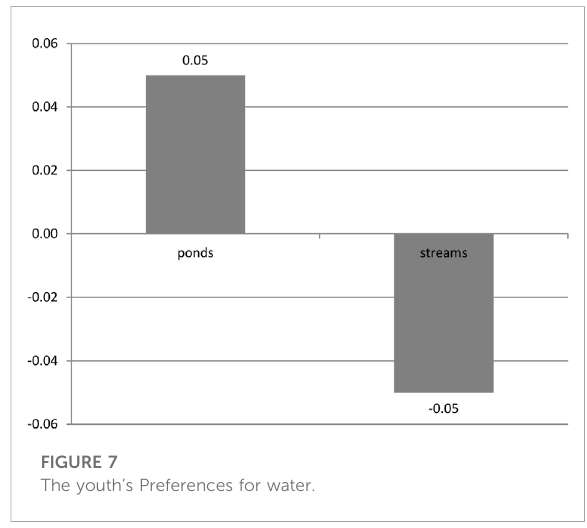
Figure 8. Indicates that ‘ straight ’ is the young adults ’ preference for the variable levels of